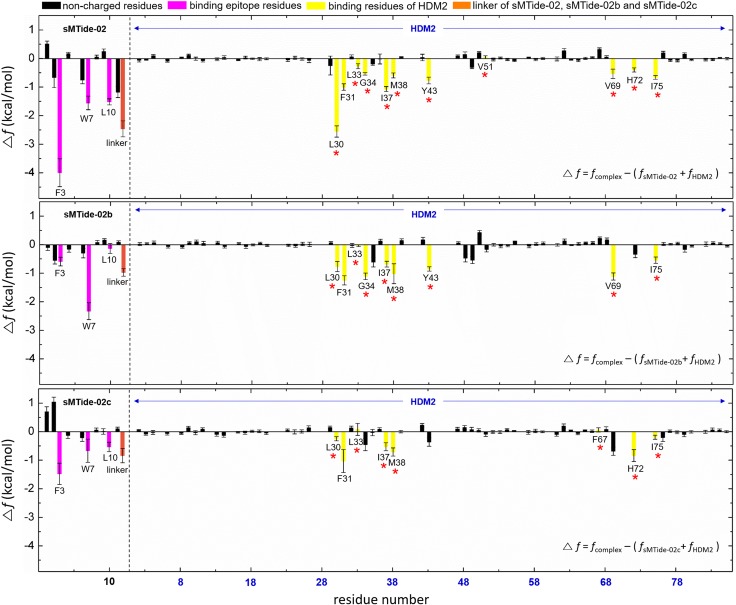
Analysis of the effective binding free energy (Δf).The epitope residues of the stapled p53 peptides are colored magenta and the hydrocarbon linker is colored orange; hydrophobic residues located at the binding interface of HDM2 are colored yellow; and residues present in the wild-type p53/HDM2 binding interface are indicated by the red stars.